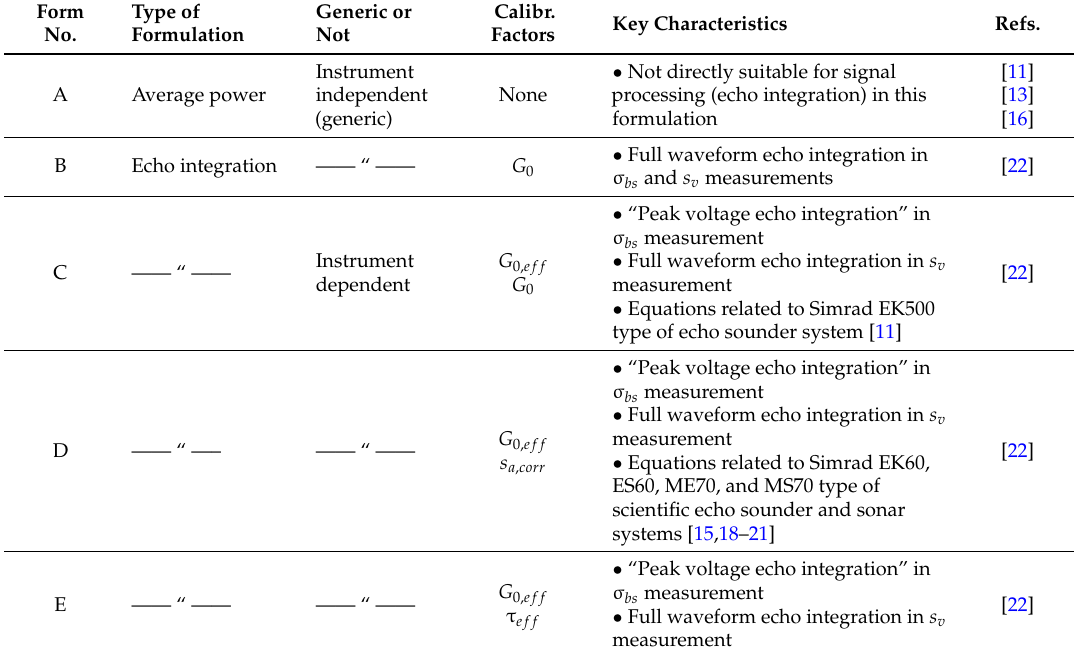
Table 1. Alternative and equivalent formulations of power budget equations for measurement of σ bs and s v . Calibration factors referred to in the table are defined in Sections 2 and 3. Form No.